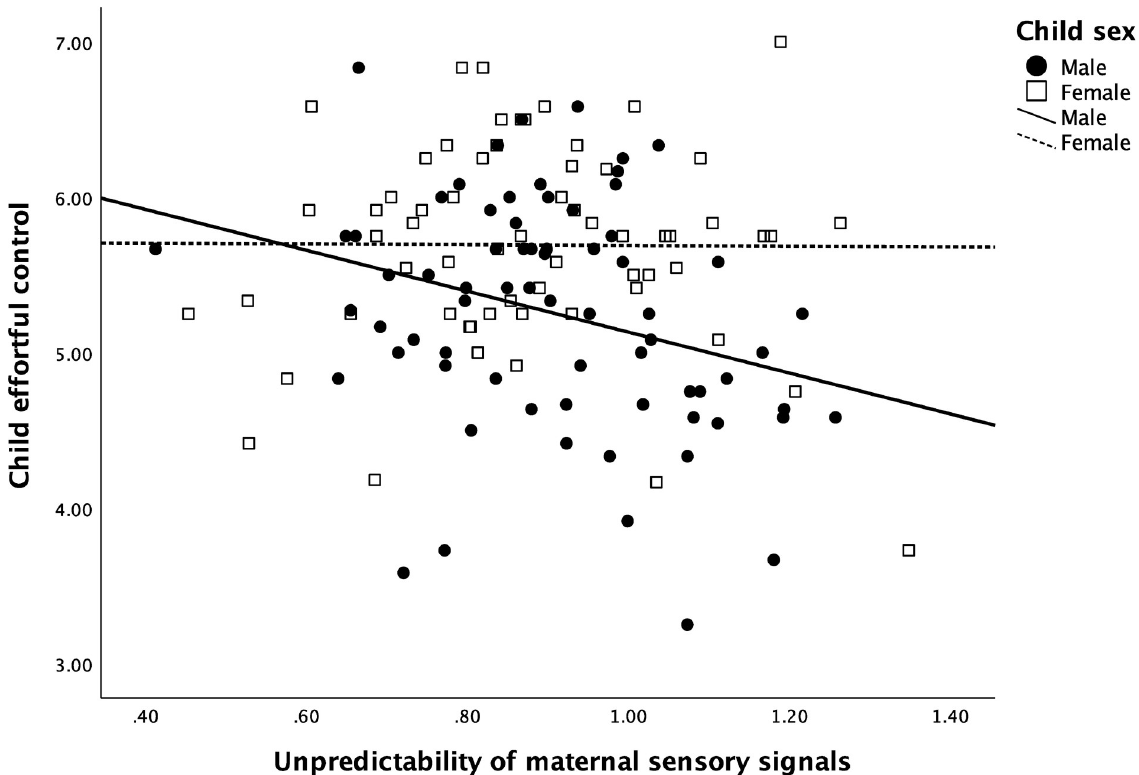
Fig 1. For males, exposure to unpredictable maternal sensory signals is related to effortful control at 5 years of age.